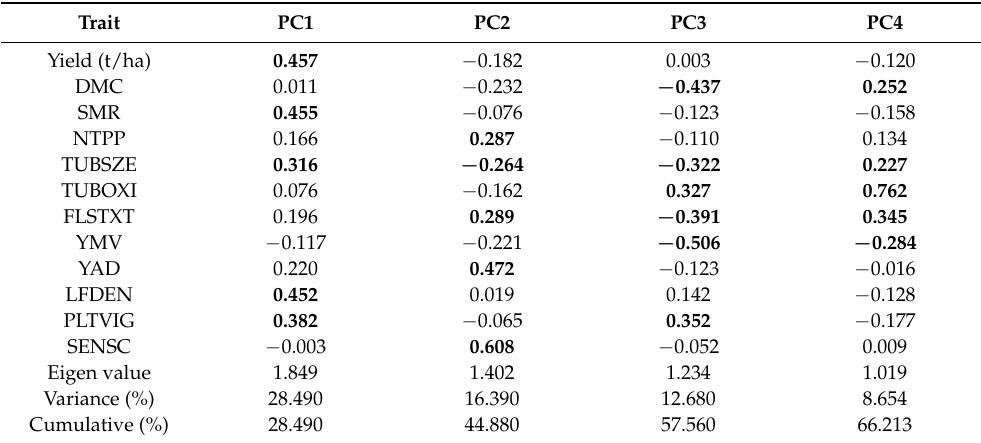
Table 6. Principal component analysis and contributions of agronomic and tuber quality traits to the genetic